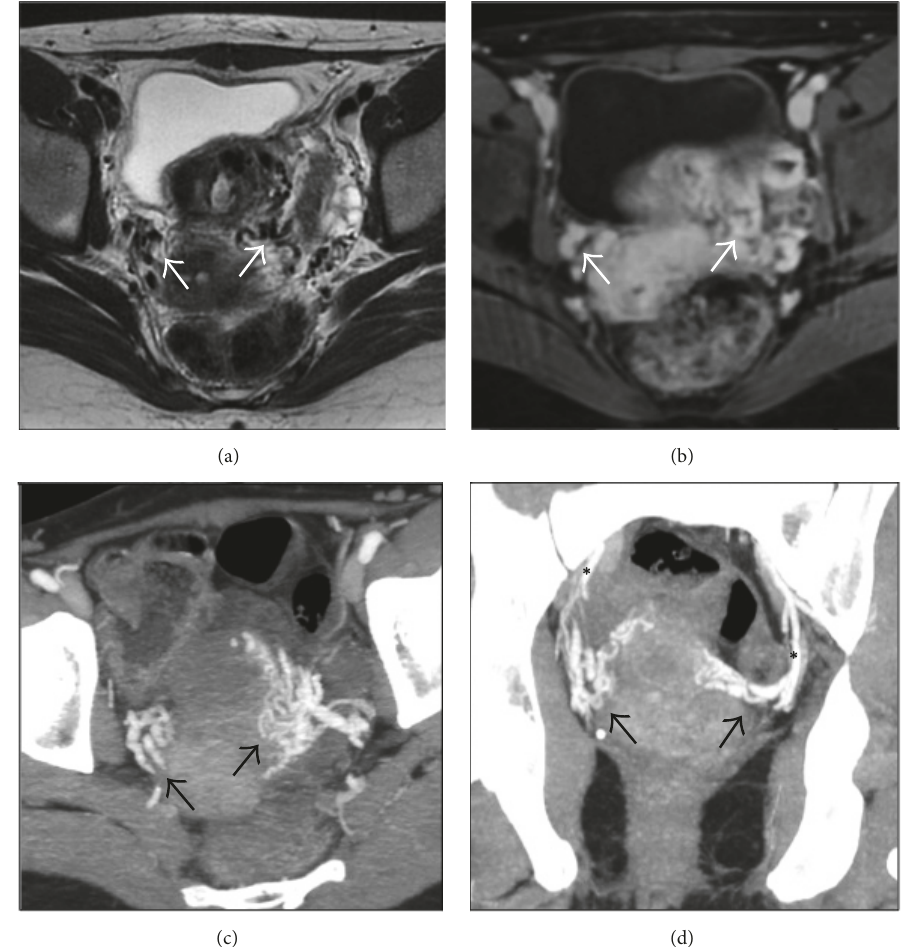
Figure 1: MR ((a) and (b)) and CT ((c) and (d)) before the embolization. (a) T2-weighted MR in axial plane; (b) contrast-enhanced T1- weighted MR in axial plane; arterious contrast-enhanced CT with maximum intensity projection in axial (c) and coronal planes (d). Multiple ectatic and serpiginous anomalous vessels adjacent to the uterine wall bilaterally are appreciable at MR and CT imaging; these are indicated by white arrows in (a) and (b) and black arrows in (c) and (d). In (d), uterine arteries, indicated by black asterisks, are in direct connection with the anomalous vessels of the uterine wall.